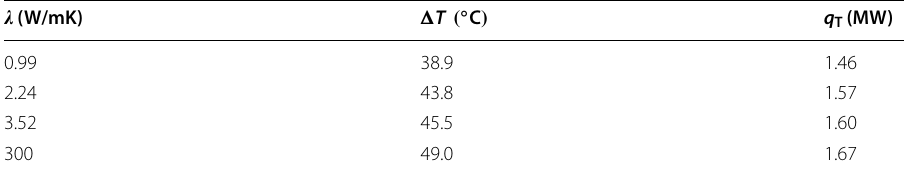
Table 10 Key thermodynamic properties for various (cid:31) (W/mK) to 3.s.f (cid:31)